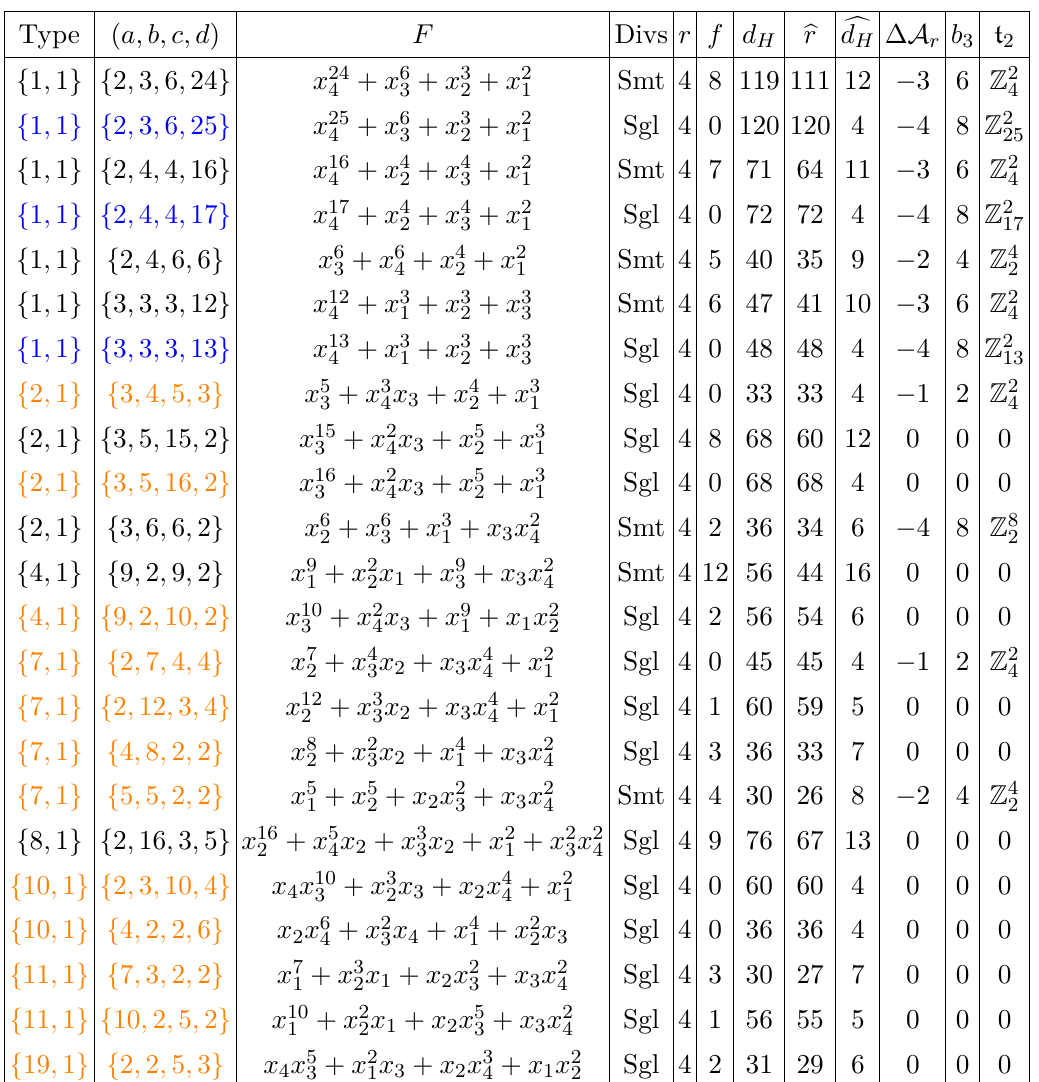
Table 21 . Rank r = 4 : smoothable models. ‘Divs’ indicates whether all exceptional divisors of the resolution are smooth (Smt) or some are singular (Sgl). The CB spectra are rather expansive and we include them instead in the ancillary mathematica